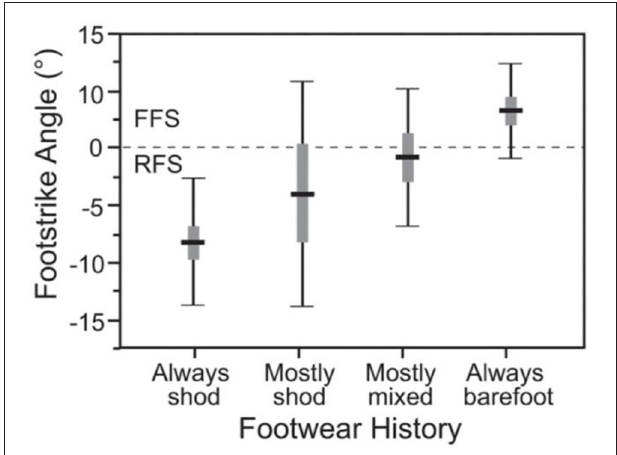
FIGURE 2 | Relationship between footwear history and footstrike angle in Kenyan runners. Note that as footwear usage decreased, runners adopted a more forefoot strike (FFS) pattern. From Lieberman et al.